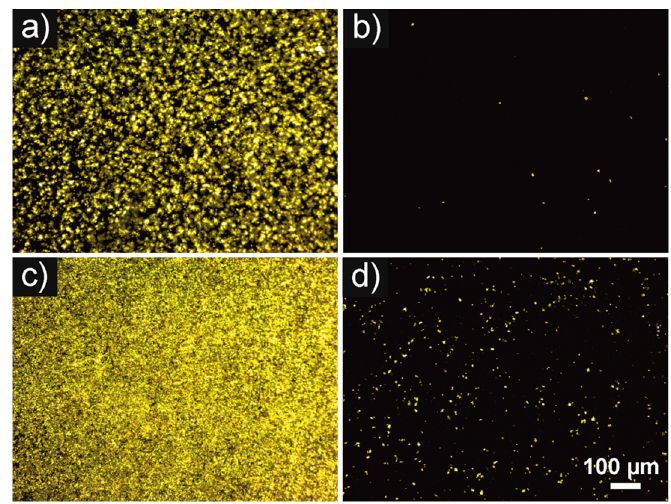
Figure 2. Representative fluorescence micrographs of uncoated ( a , c ) and phenox’s “Hydrophilic Polymer Coating” (pHPC)-coated ( b , d ) NiTi ( a , b ) and CoCr ( c , d ) specimens. The plates were incubated in whole human blood for 10 min under dynamic conditions. Adherent platelets were stained with a CD61 antibody (yellow fluorescence). (Scale bar for all images 100 µ m.)